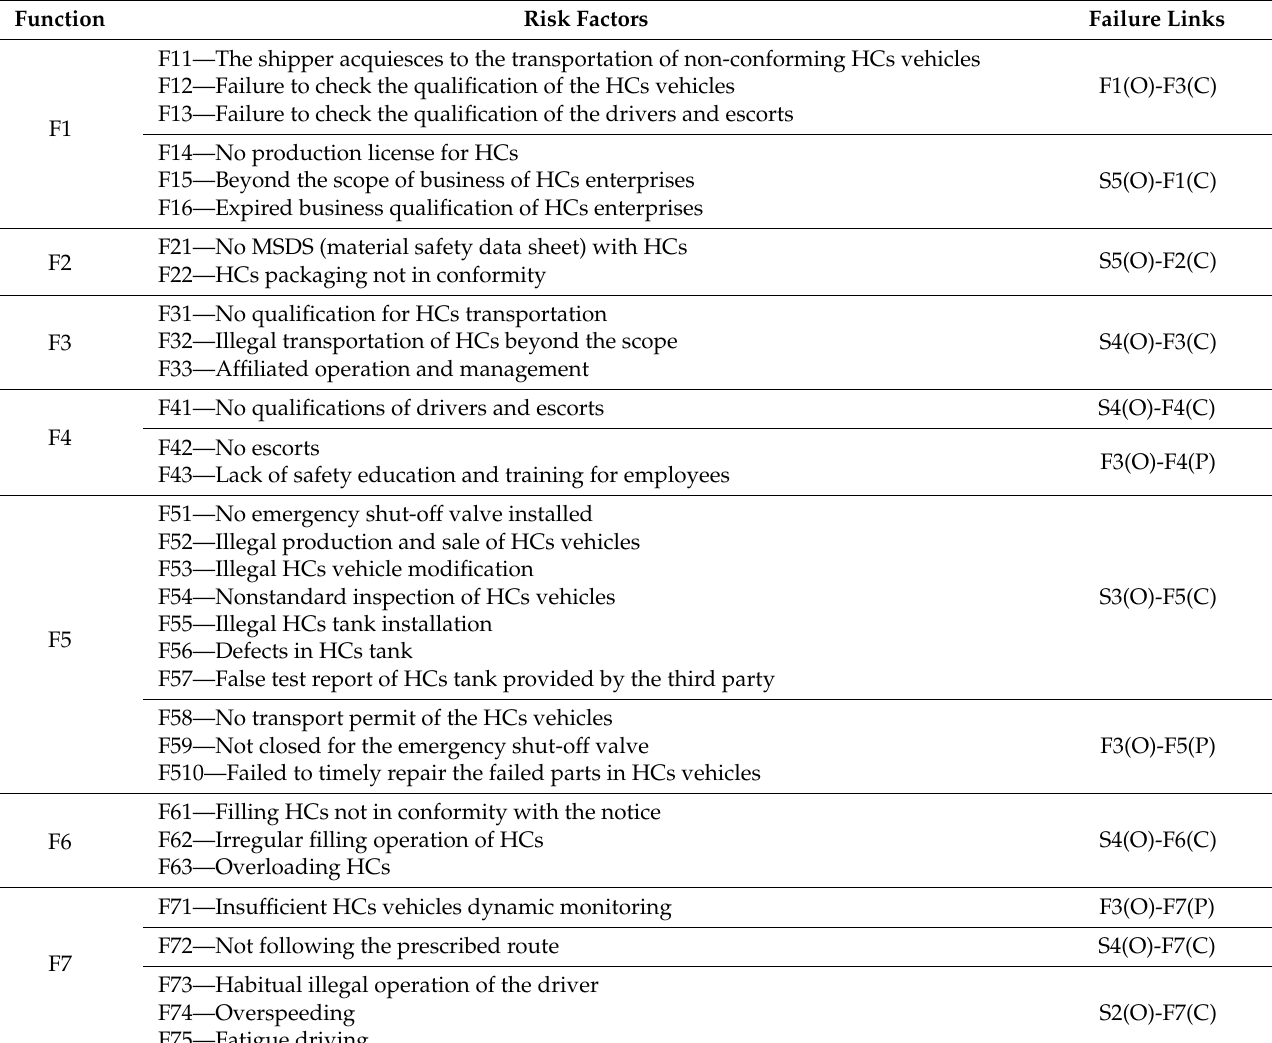
Table 2. Risk factors and their corresponding failure links in